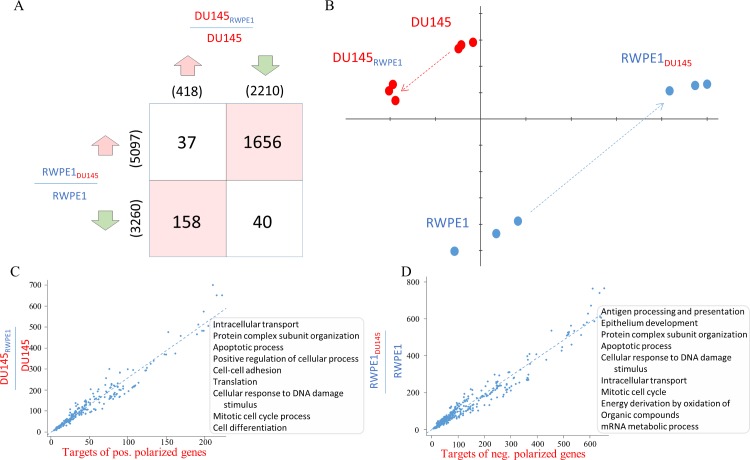
In vitro normal and tumour cell co-culture model.The results of the in vitro cell co-culture experiment used to analyze normal and tumour epithelial cells crosstalk. (A) Table showing the number of overlapping genes between differentially regulated gene lists in normal and tumour cells as a result of co-culture. Rows in the table represent up and down regulated genes in normal cells whereas columns are up and down regulated genes in tumour cells. There is a significant overlap in gene lists changing in opposite directions (p<0.0001, red background). (B) PCA plot representing normal and tumour cells cultured on their own (RWPE1 and DU145) or in co-culture (RWPE1DU145 and DU145RWPE1). (C-D) Scatterplots comparing the number of genes in functional terms represented in the predicted targets of polarized genes and genes differentially expressed in the co-culture model. Panel C represent tumour cells whereas panel D represent normal cells.